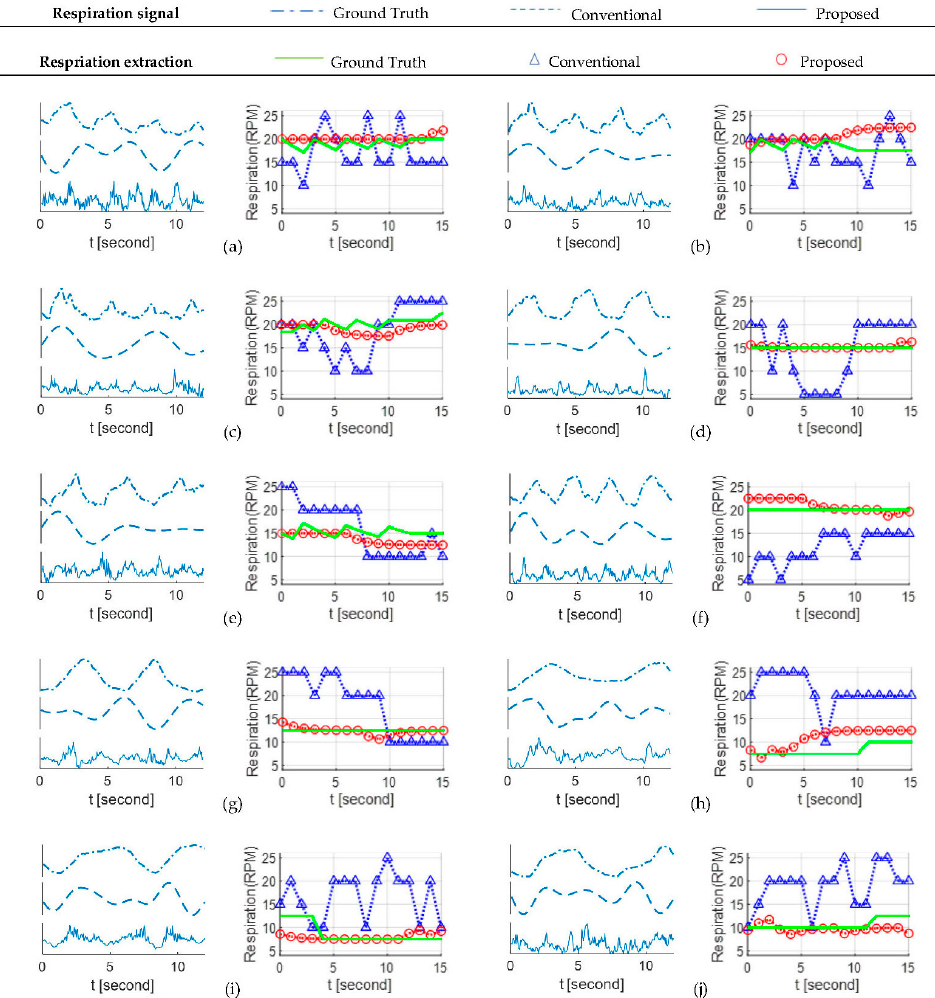
Figure 10. Respiration extraction results for the case shown in Figure 5c. ( a ) Subject #1, ( b ) Subject